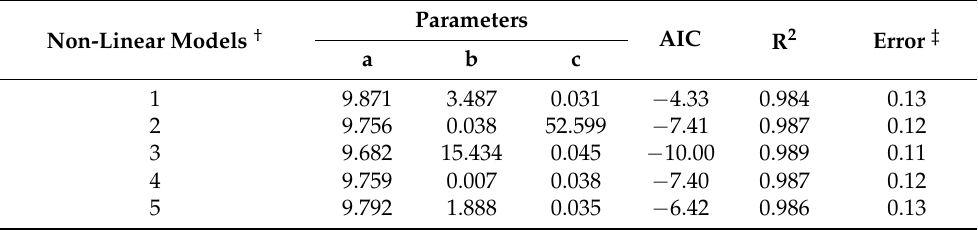
Table 1. Estimated biological parameters, values of Akaike’s information criterion (AIC), coefficient of determination, and absolute error of the adjusted models for the estimation of water disappearance in the growing–finishing phase, according to the pigs’ age.